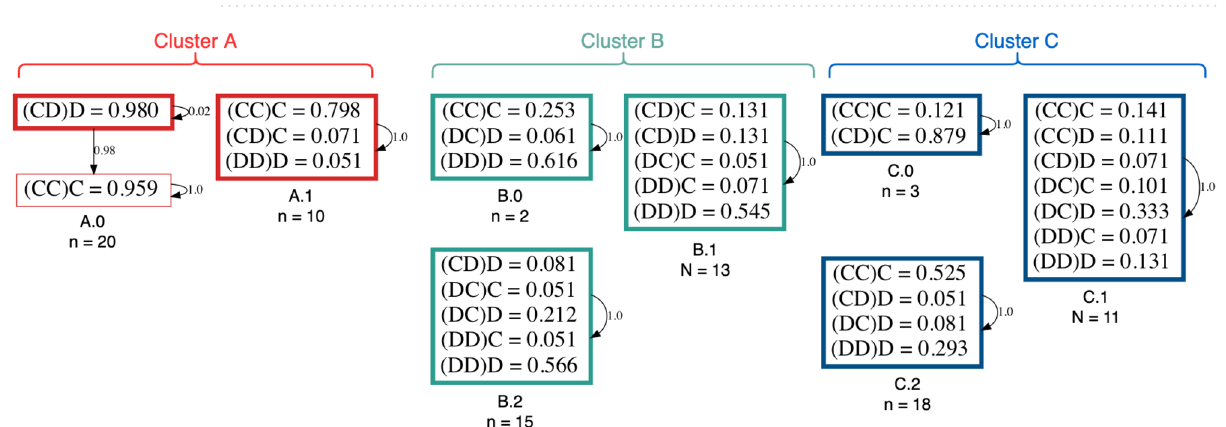
Figure 4. Probability of cooperation given each context per cluster for the FP treatment. In each plot, the conditional probability of cooperating for each context is given. The bars represent the binomial error. Each contextual cluster is divided into sub-clusters that were identified using the frequency of cooperation given a context.